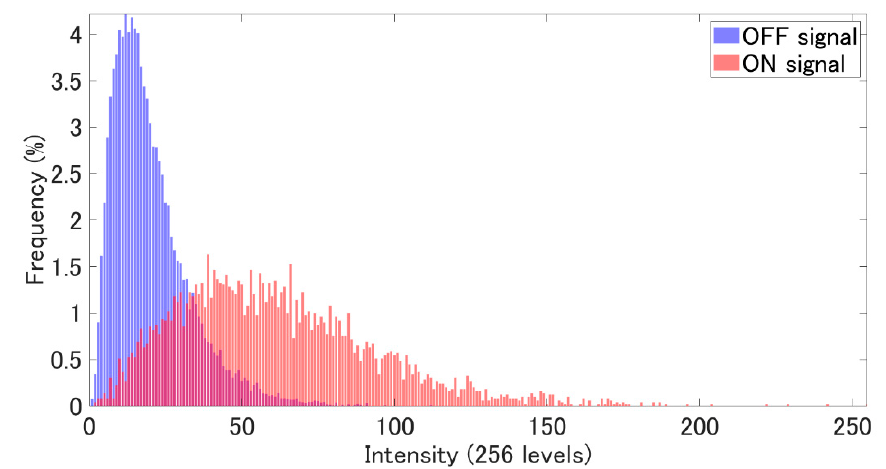
Figure 6. Histogram of the reconstructed signal area in case of three multiplexed hologram, SNR = − 0.9